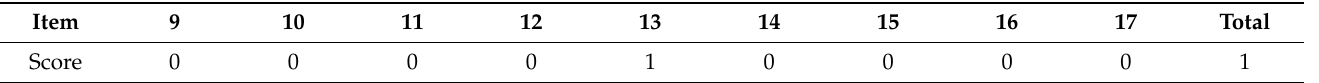
Table 3. Anna’s scores on the nine items of the subcomponent Education/Employment